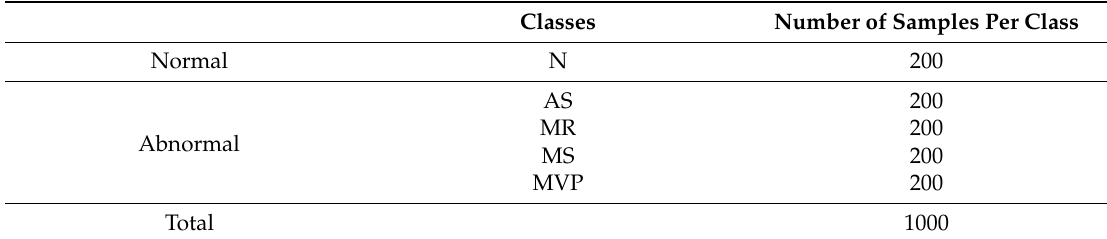
Table 1. Dataset Table 1. Dataset detail.